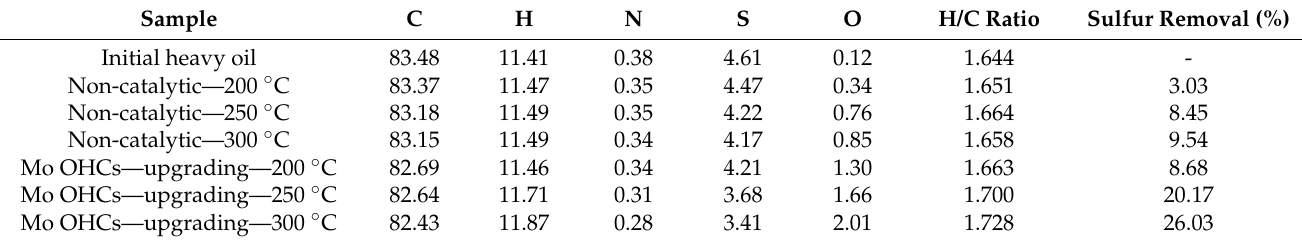
Table 5. Elemental analysis of oil before and after upgrading in the presence and absence of MoOC